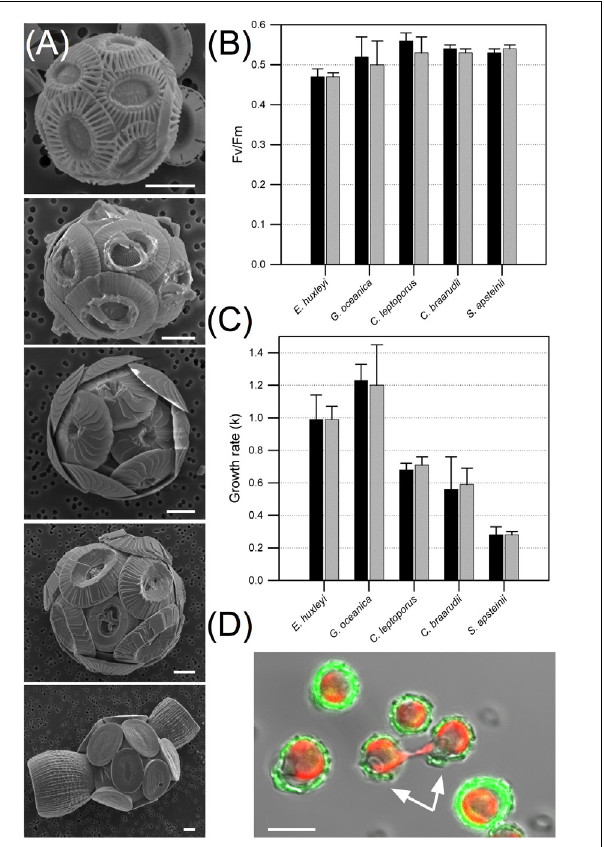
FIGURE 5 | Growth, physiology and coccolith structure are unaffected by calcein treatment. (A) Scanning electron micrographs showing representative coccolithophore cells treated for 2 h with calcein in buffered seawater media. Species from top; Emiliania huxleyi , Gephyrocapsa oceanica , Coccolithus braarudii, Calcidiscus leptoporus, and Scyphosphaera apsteinii . Scale bars represent 2 µ m. (B) Quantum yield of photosystem II ( F v / F m ) of dark adapted cells processed for 2 h in the presence (gray bars) and absence (DMSO only, black bars) of calcein ( N = 4 independent replicates for each species ± SD, no significant differences with t -test, p (cid:61) 0.1). (C) Growth rates ( k ) of coccolithophores determined over 8 days post-calcein staining (gray bars) compared to 2 h treatment with DMSO solvent alone (black bars; N = 3 independent replicates for each species ± SD, no significant differences with t -test, p (cid:61) 0.4). (D) Dividing E. huxleyi cells (indicated with white arrows) 8 h after calcein labeling. Scale bar represents 5 µ